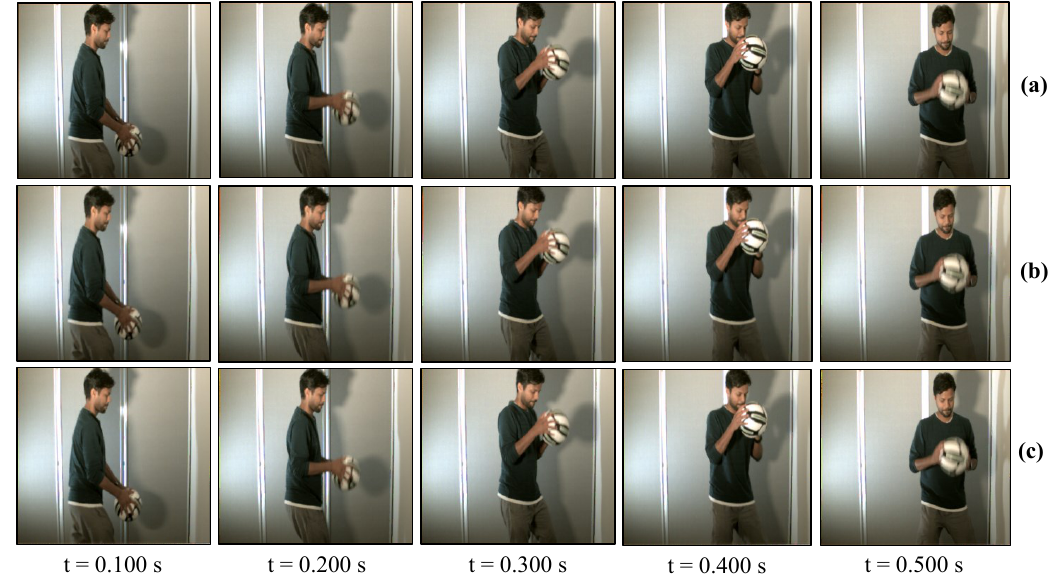
Figure 19. Reconstructed USB camera input image sequence on the plain background: ( a ) 640 × 480 input image; ( b ) 510 × 459 binary-code image without background subtraction; and ( c ) 510 × 459 binary-code image with background subtraction.